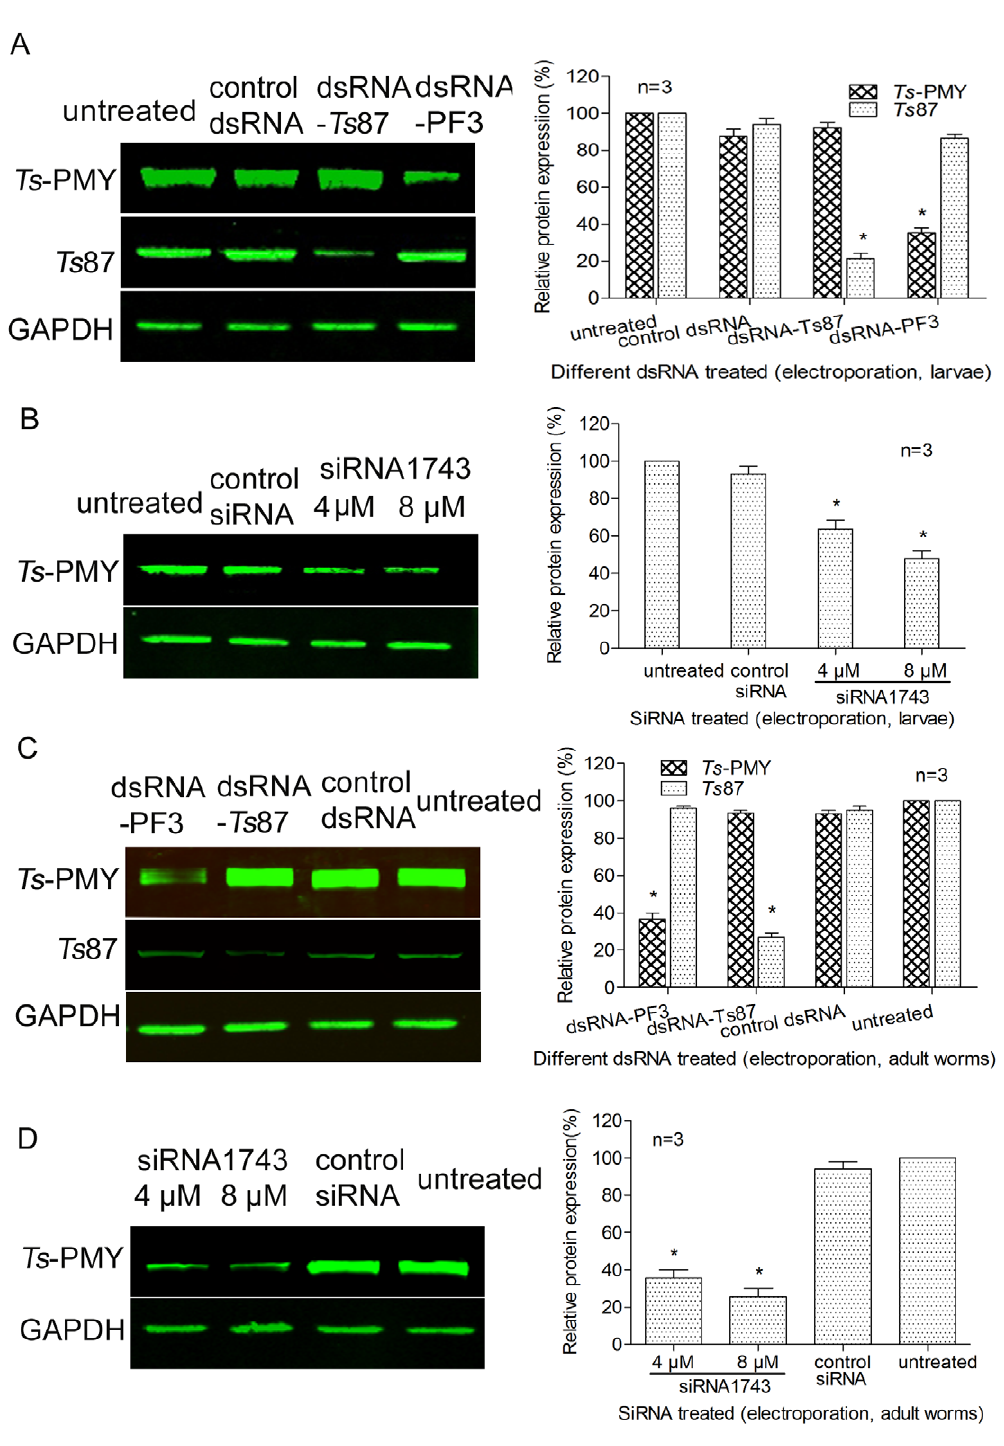
Figure 4. The silencing of Ts- PMY protein expression mediated by siRNA or dsRNA. Western blot with specific antibodies showing the specific inhibition of Ts -PMY protein expression in extracts of T. spiralis larvae (A, B) and adult worms (C, D) induced by dsRNA-PF3 (A, C) or siRNA1743 (B, D). Graphs on the right show the relative protein levels measured by densitometry from three independent experiments. * p , 0.05 compared with the control dsRNA/siRNA-treated group.